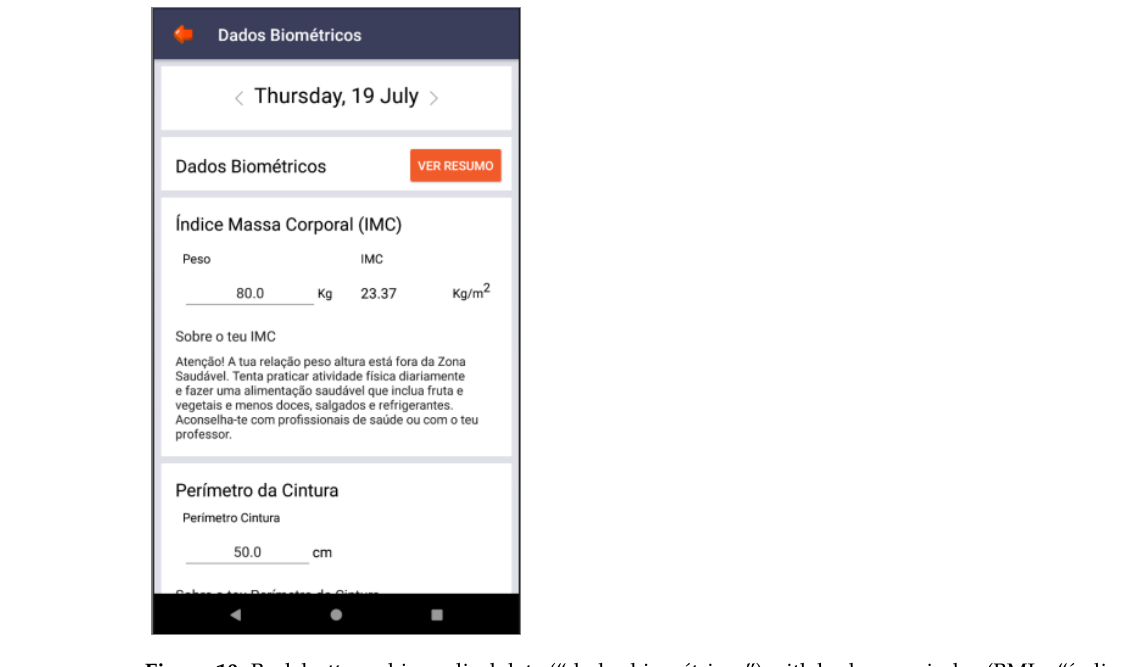
(meat=”carne”, dairy=”lacticínios”,…) and the major categories missed in that meal (fruit=”fruta”,